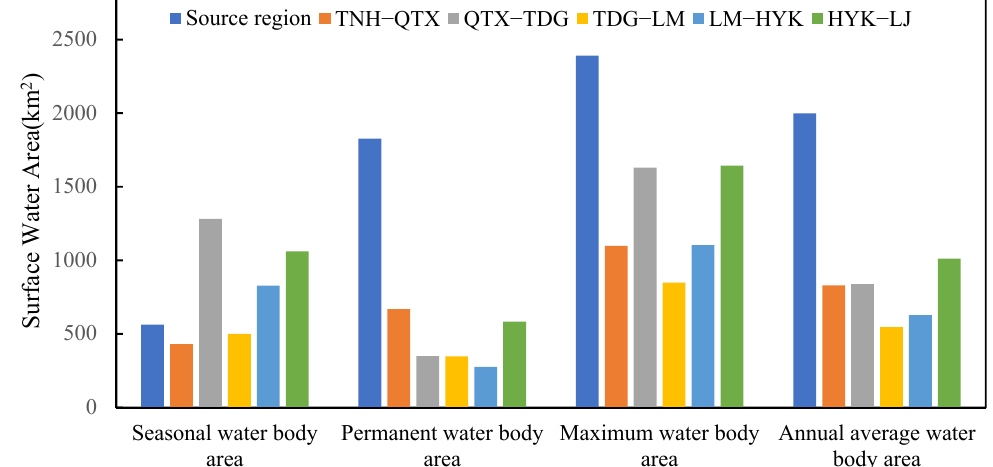
Figure 7. The areas of the different types of surface water bodies derived from the multi-year average WIF during 1986–2019 in the YRB.